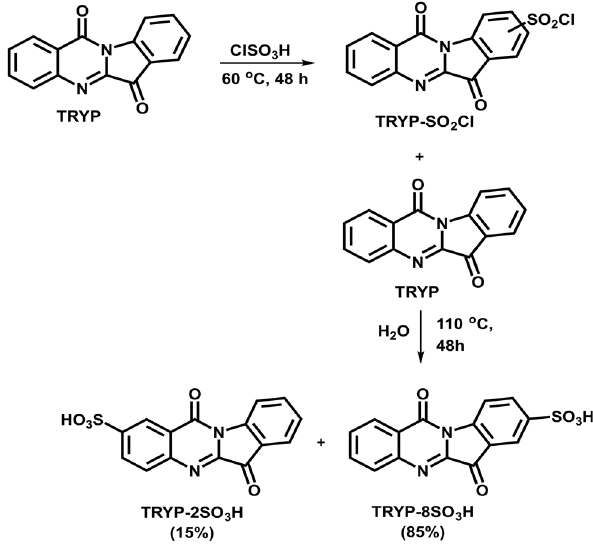
Fig. 1 Schematic synthetic route. Tryptanthrin sulfonyl chloride derivatives and tryptanthrin sulfonic acid